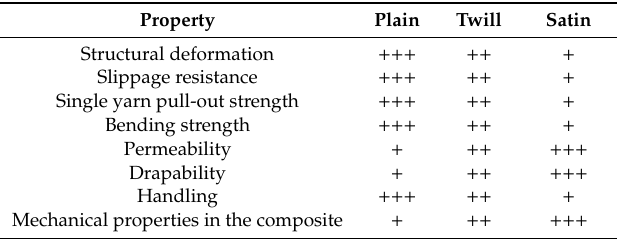
Table 1. Overview of properties of di ff erent weave patterns used composite applications [15]. Property Plain Twill Satin Structural deformation